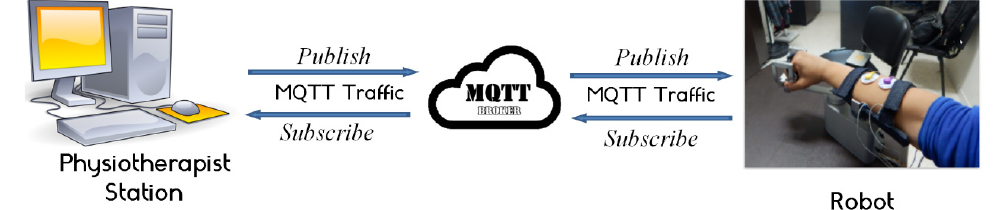
Table 2. Wrist RoM for a healthy Figure 13. IoT platform.